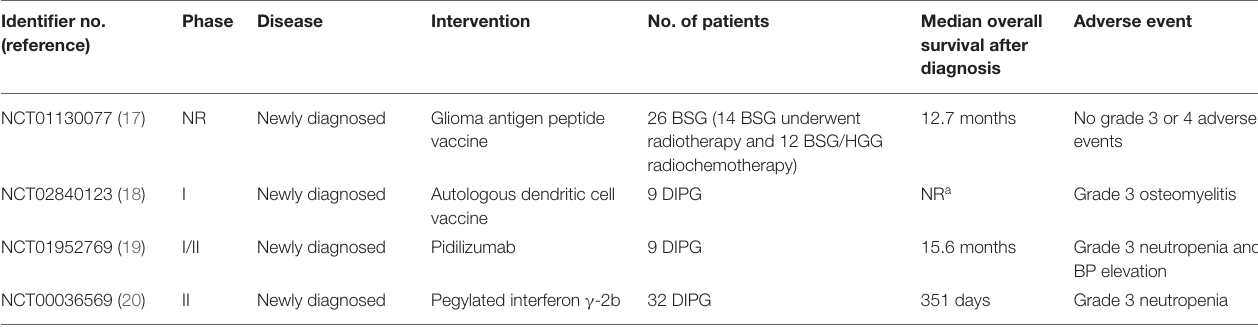
TABLE 2 | Results of clinical trials of immunotherapy in pediatric patients with diffuse intrinsic pontine/midline glioma. Identifier no.